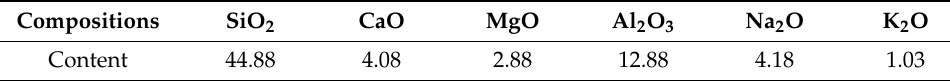
Table 2. Chemical compositions of bentonite (mass/%).